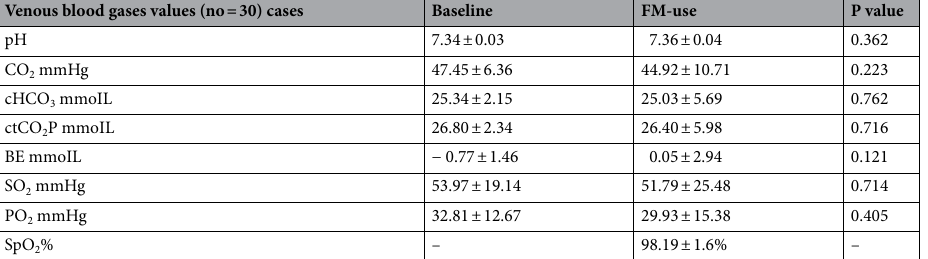
Table 4. Venous blood gases (VBGs): baseline vs. facemask wearing and peripheral oxygen saturation (SpO 2) under facemask wearing. FM, facemask; pH, potential hydrogen; CO 2 , carbon dioxide; cHCO 3 , concentration of hydrogen carbonate; ctCO 2 , total carbon dioxide concentration in plasma; BE, base excess; SO 2, oxygen saturation; SpO 2, peripheral oxygen saturation. Differences between dependent variables were analyzed using Student’s T test for paired samples or Wilcoxon